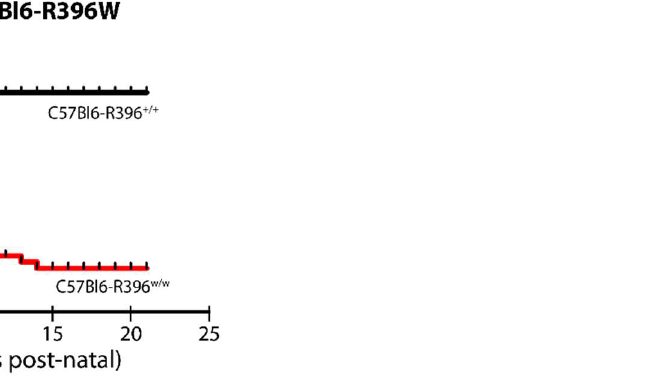
Figure 1. Postnatal lethality in C57Bl6-R396 w/w mutant pups. Cages were monitored daily until weaning (day 21) and cadavers were genotyped. Percent survival for wild-type and homozygous mutants is shown.